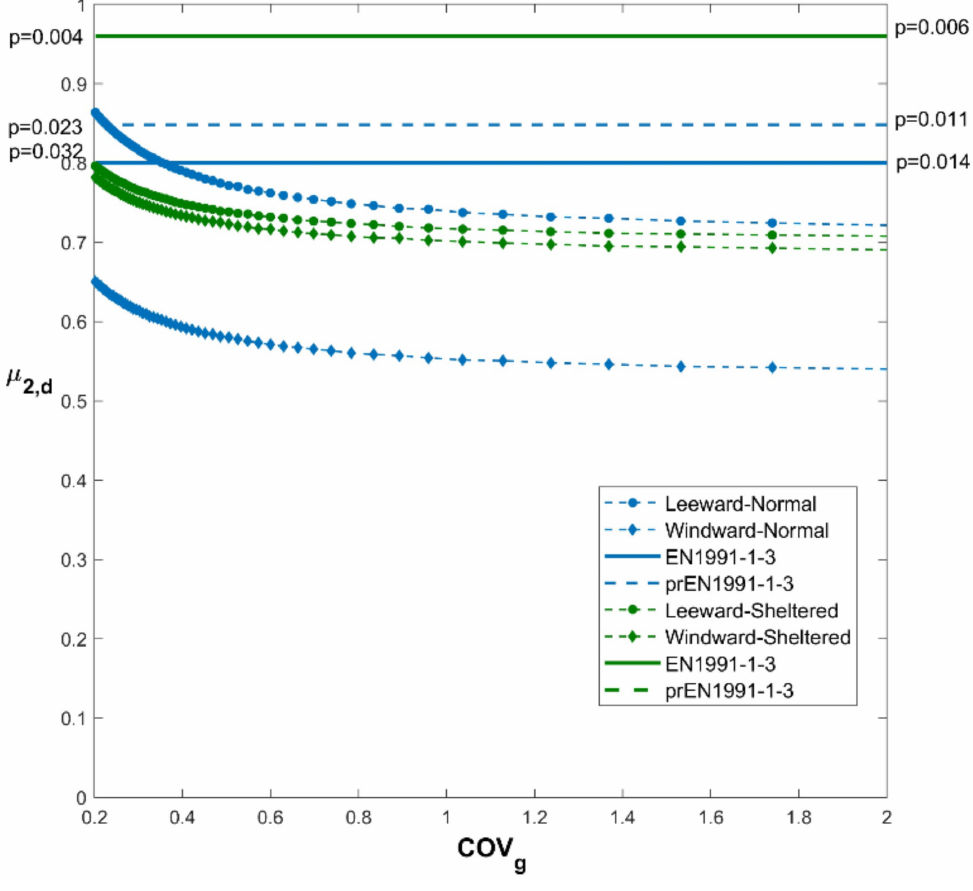
Figure 8. Design shape coefficient for pitched roofs ( µ 2, d ) with 10 ◦ < α < 15 ◦ as a function of the coefficient of variation ( COV g ) of ground snow load, parameterized in terms of exposure conditions (sheltered: green lines, normal: blue